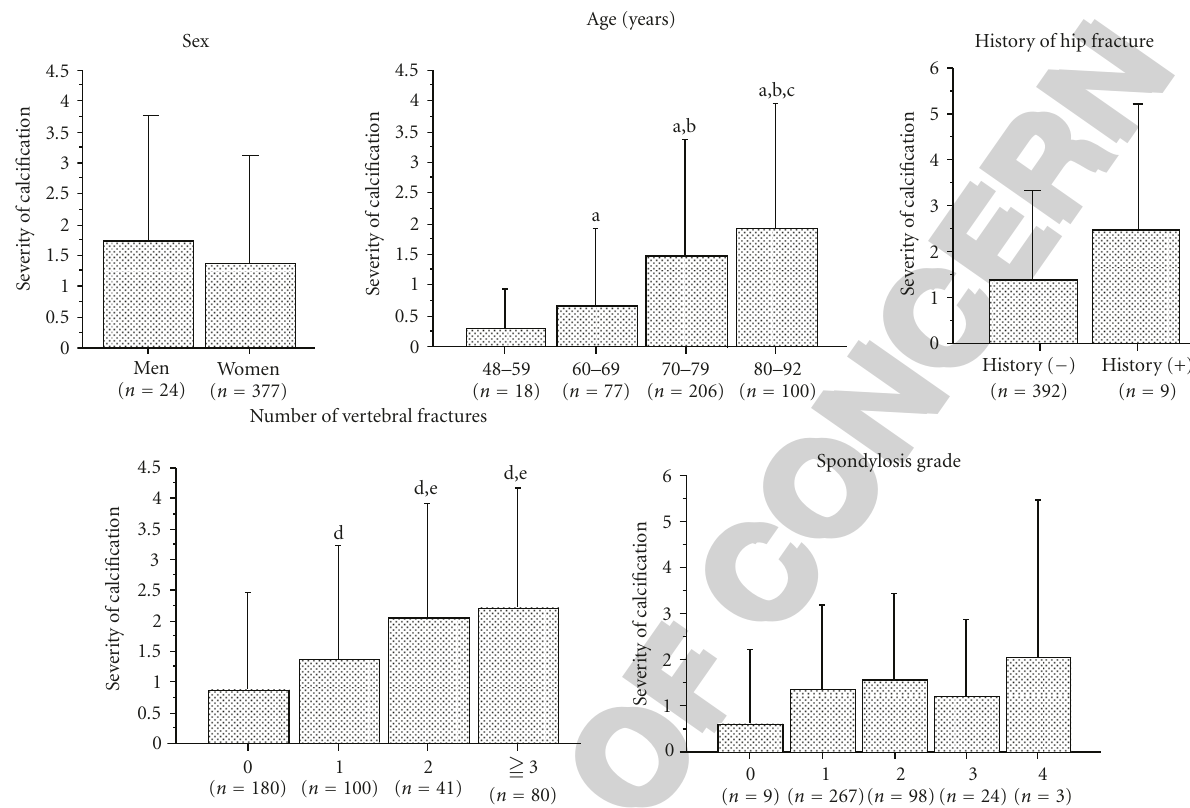
Figure 3: Relations between the severity of abdominal aortic calcification and five factors. Data are expressed as the mean ± standard deviation (SD). Data comparisons among groups were performed using an analysis of variance (ANOVA) with Fisher’s protected least significant di ff erence (PLSD) test. (a) Significant versus the 48–59 years of age group, (b) significant versus the 60–69 years of age group, (c) significant versus the 70–79 years of age group, (d) significant versus the no prevalent vertebral fracture group, and (e) significant versus the one prevalent vertebral fracture